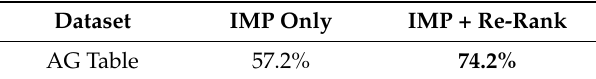
Table 2. The accuracies of entity annotations on AG Table datasets based on using only IMP model and IMP plus Re-Rank model. The value in bold is the accuracy of IMP plus Re-Rank model which show that the result improves a lot compared with using only IMP